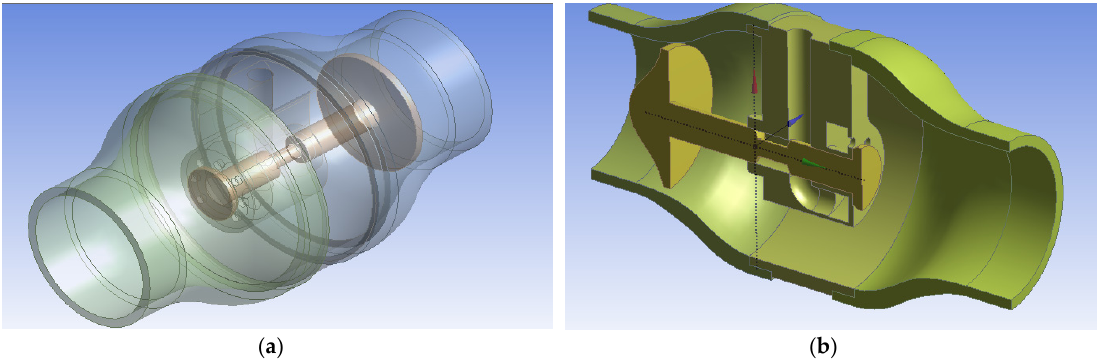
Figure 4. The geometry of the mixer after drawing using the ANSYS workbench software: ( a ) Isometric view of mixer; and ( b ) Section view of mixer